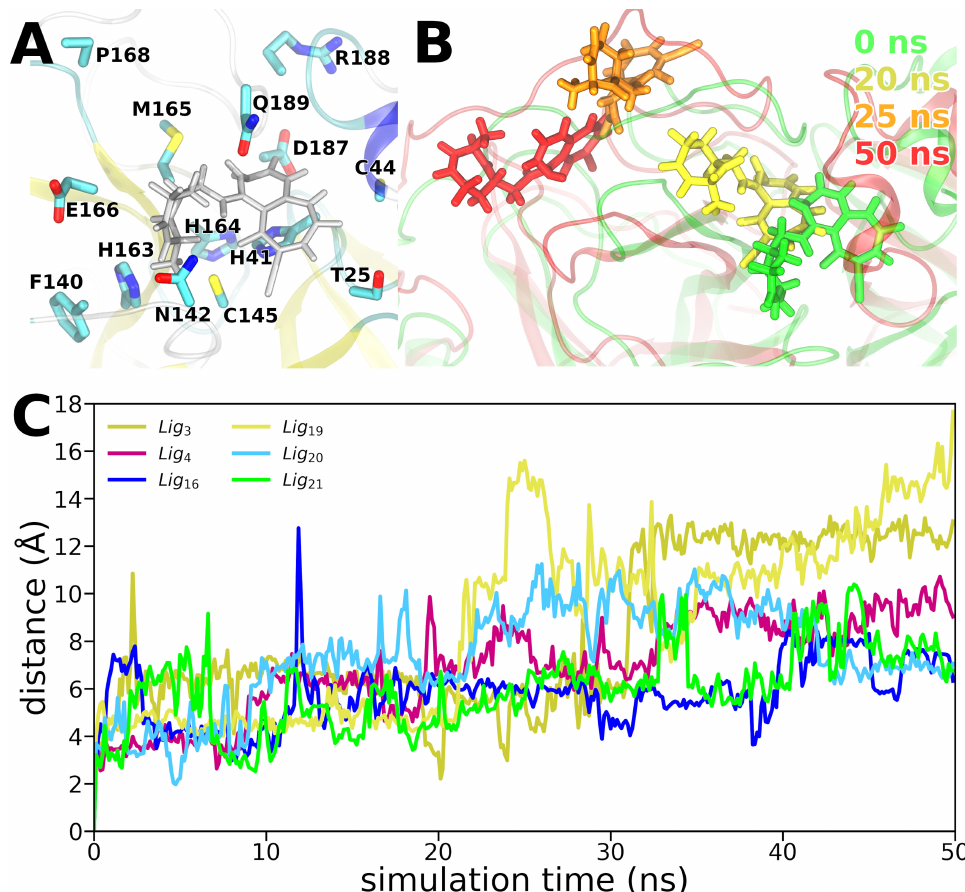
Figure 8. ( A ) Binding site of M pro defined by the labeled residues [66] with Lig 19 in its initial bound pose illustrated in gray. ( B ) Position of Lig 19 in M pro after 0 ns (green), 20 ns (yellow), 25 ns (orange), and 50 ns (red) of simulation. ( C ) Time evolution of the center of mass (COM) distance between the M pro binding site and the ligands that drifted away from the binding site during the ligand–receptor complex simulations. Each data point was averaged over a time window of 125